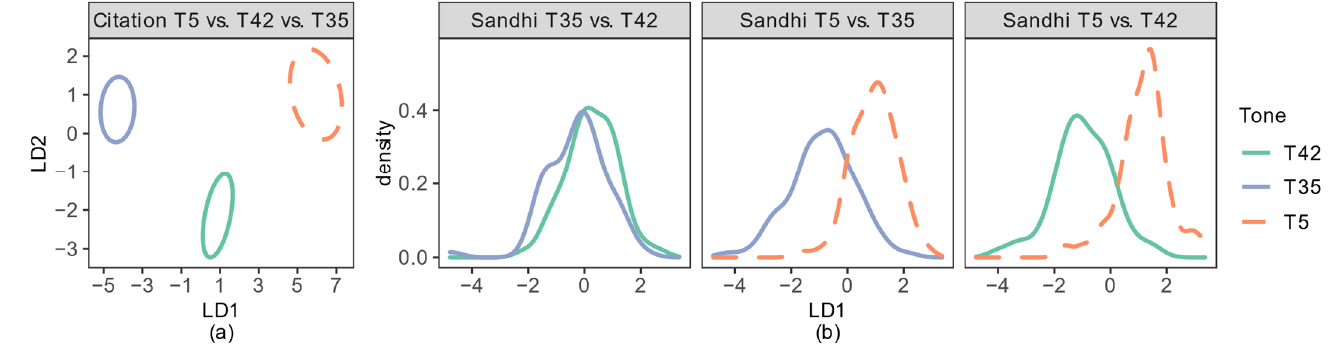
Figure 12. ( a ) is the LD1-LD2 distribution of T5 vs. T42 vs. T35 in citation forms. The ellipses represent 50% confidence intervals around the mean of each group. ( b ) is the LD1 distribution of T35 vs. T42, T5 vs. T35, and T5 vs. T42 in sandhi forms, respectively. LD1 and LD2 are from the models without cross-validation.